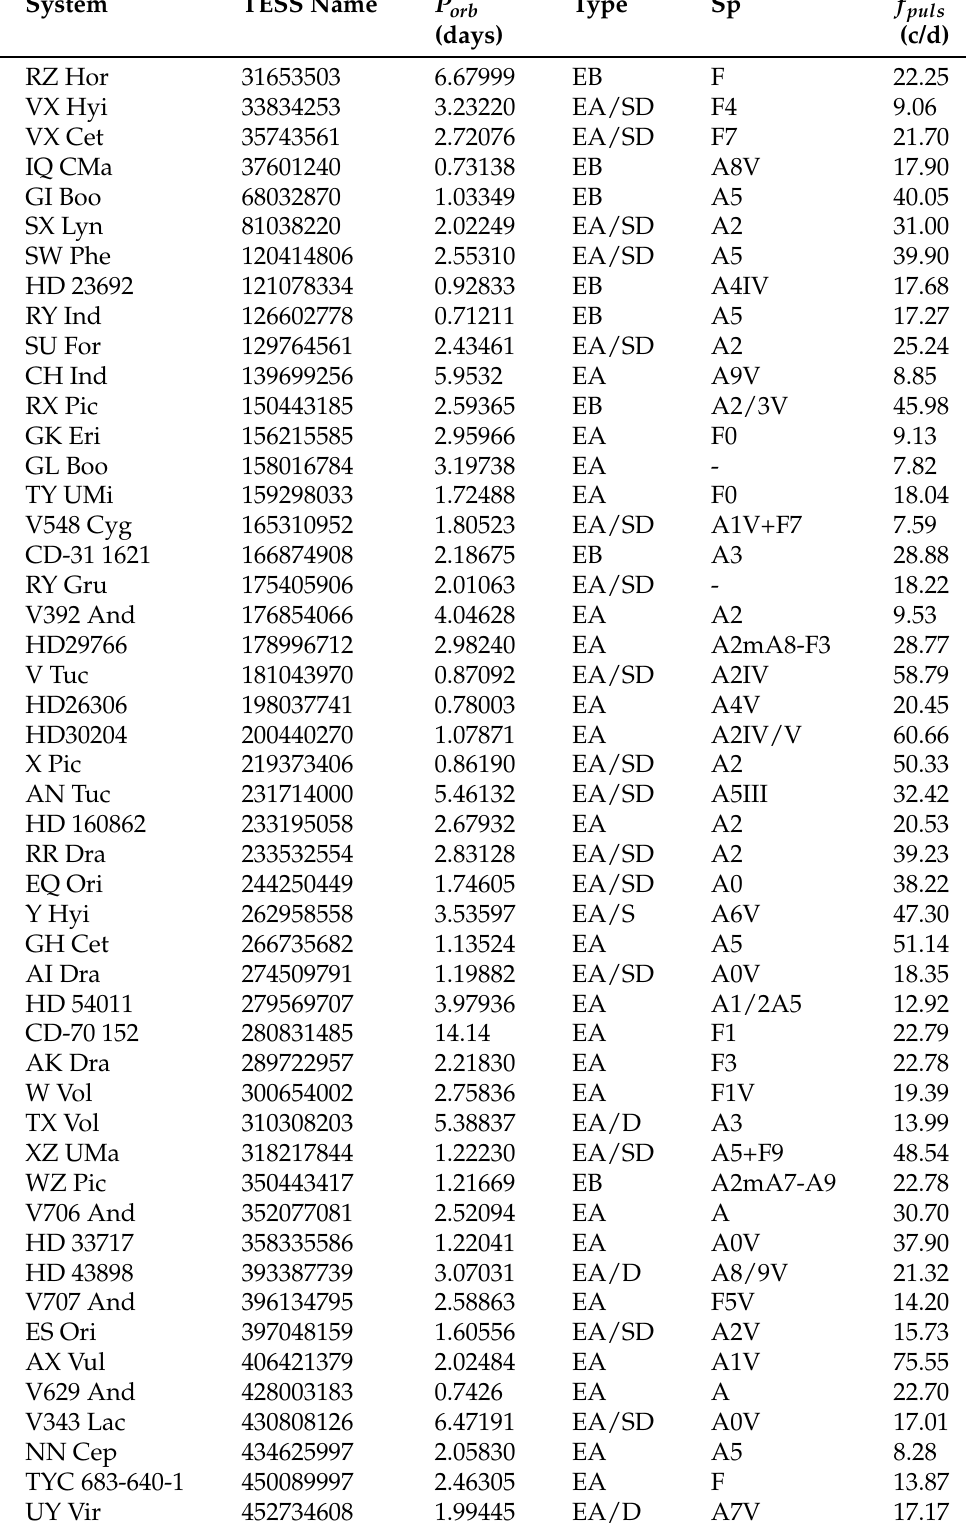
Table 1. The list of 49 new oEA and EA/DSCT stars discovered by us in the TESS light curves. A number of the pulsating components of eclipsing systems have uncertain detached/semi-detached configurations; they need further clarification of their binary configurations. The pulsation frequency f puls is given for the mode of the highest photometric amplitude. The orbital periods and pulsation frequencies are listed with five- and two-digit precision,